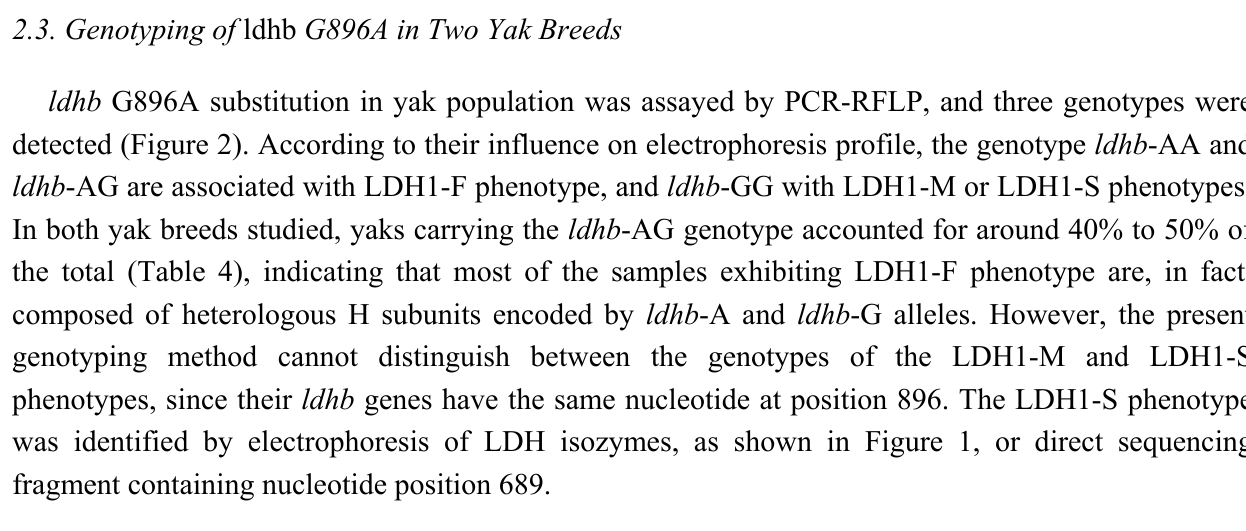
Table 4. Genotype and gene frequencies of ldhb G896A mutation in two yak